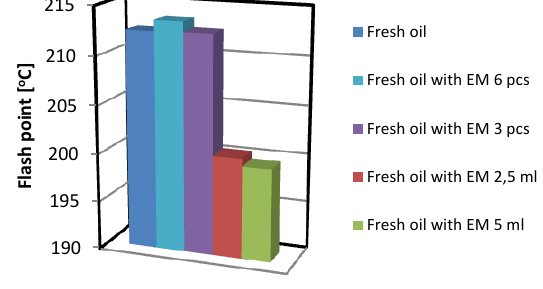
Fig. 7. Flash point oil of fresh oil and fresh oil with EM in liqiud form and ceramic tubes